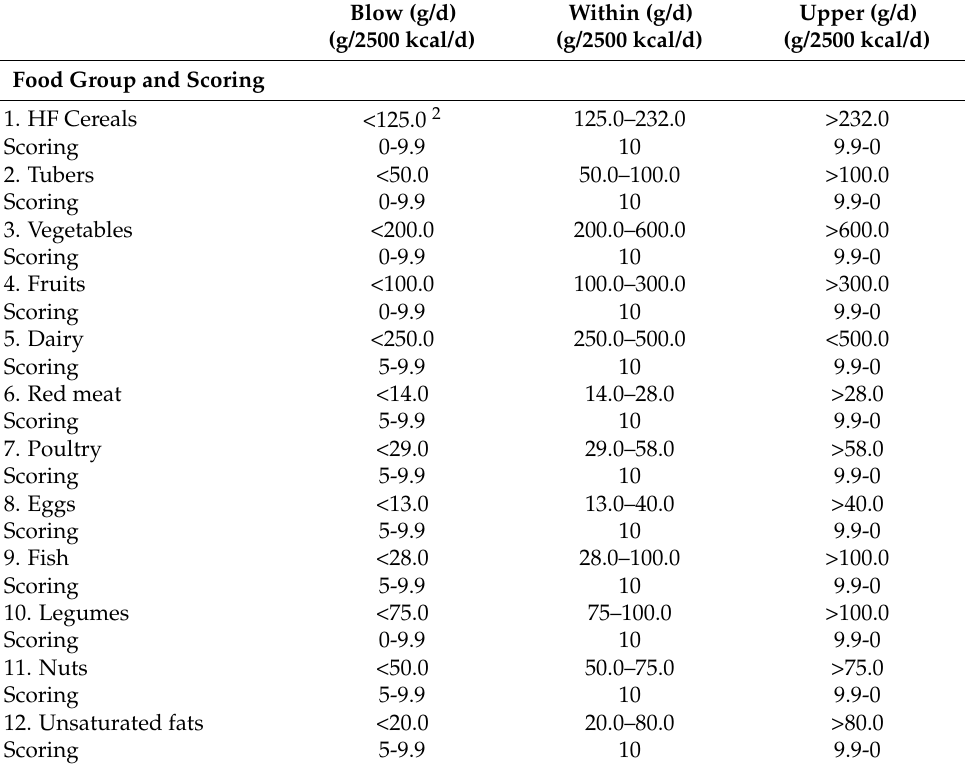
Table 1. Lower, Optimal, and Upper Food group limits and Scoring 1,4 .